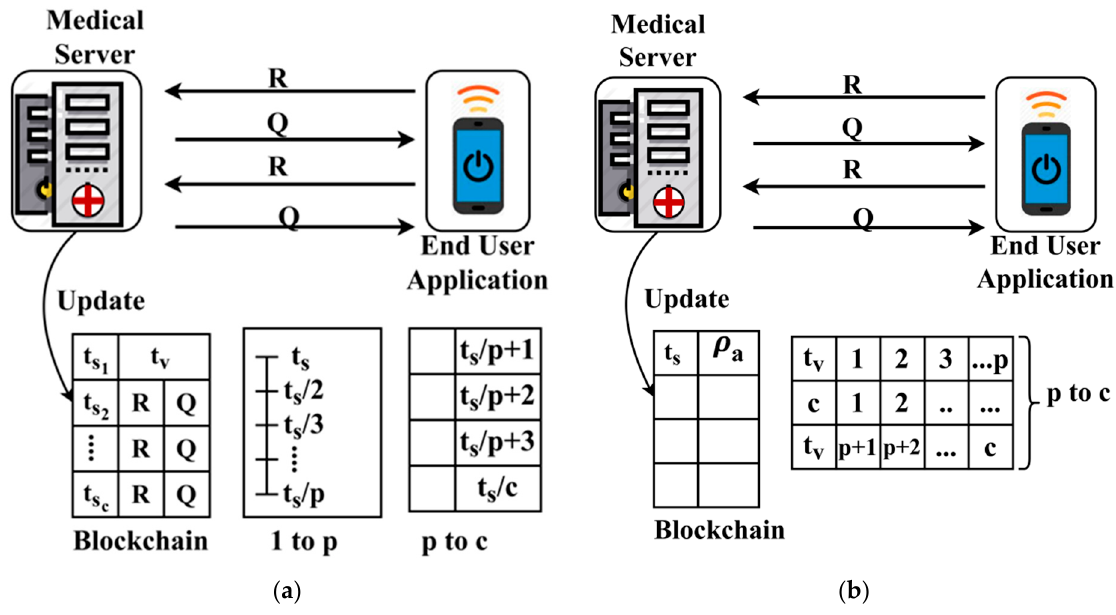
Figure 3. ( a ) Sequential update (1 to p), ( b ) concurrent update (p to c). Table 3. Records Classified under Table 1 Condition.